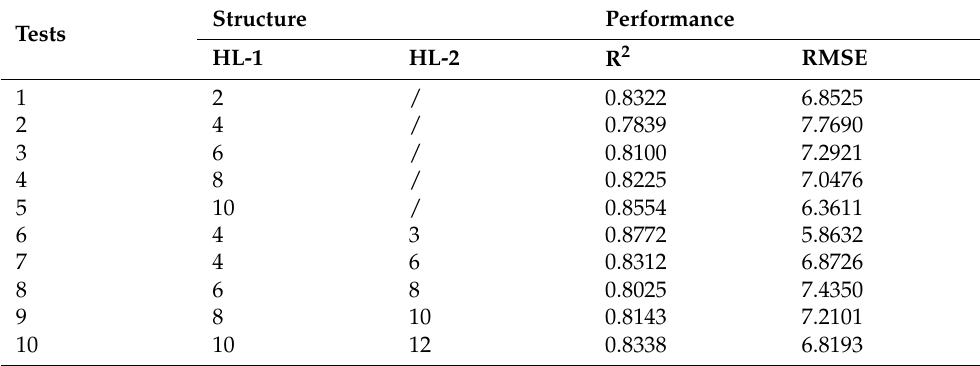
Table 3. Performance of the ANN model with different hidden layers and neuron